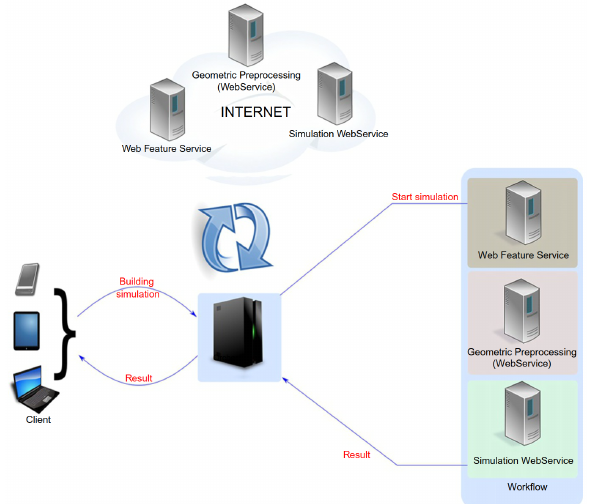
Figure 3. Service oriented architecture for energy